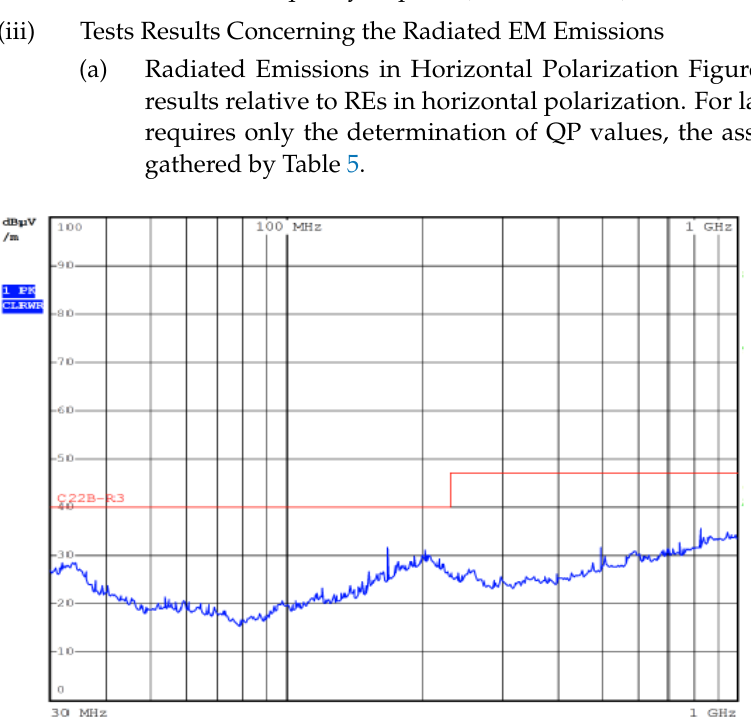
Figure 15. Radiated emissions in horizontal polarization for a laptop. (b) Radiated Emissions in Vertical Polarization